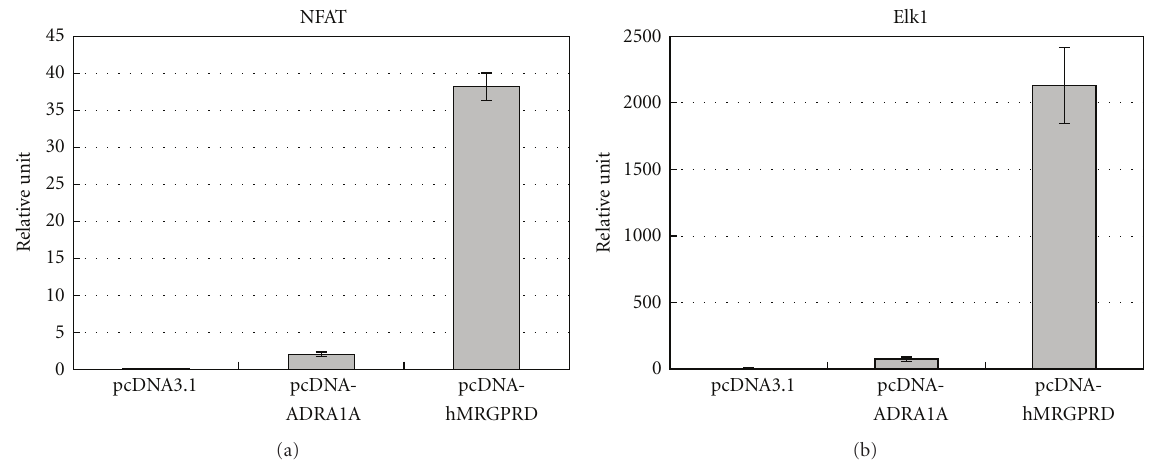
Figure 1: Signaling pathways of MRGPRD. Representative graphs of relative luciferase intensity of (a) NFAT and (b) Elk1. The results are the average of three independent